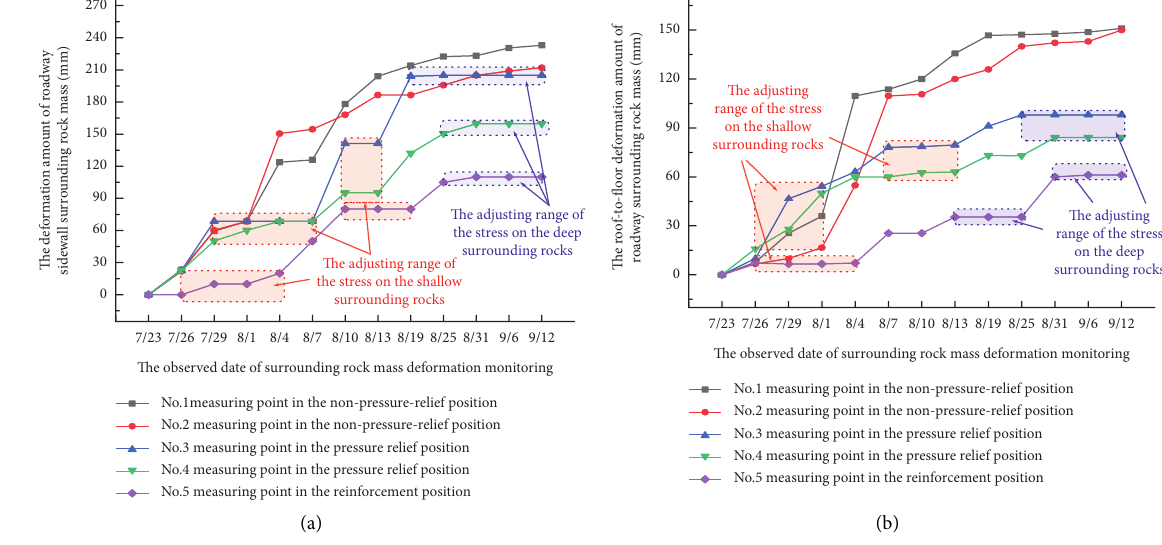
Figure 17: Deformation of surrounding rock mass: (a) convergence on both sides of roadway; (b) roof-to-floor convergence of